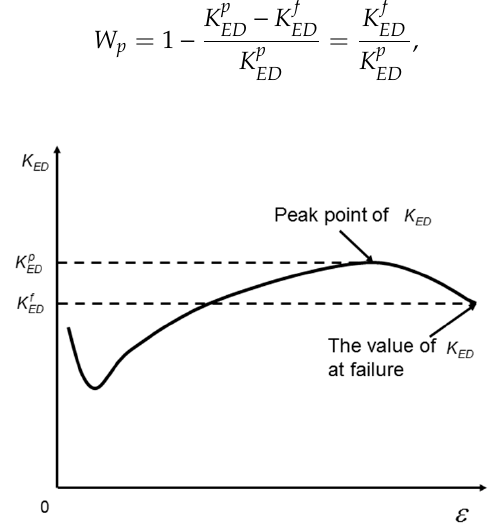
Figure 11. Calculation of the energy preservation index.